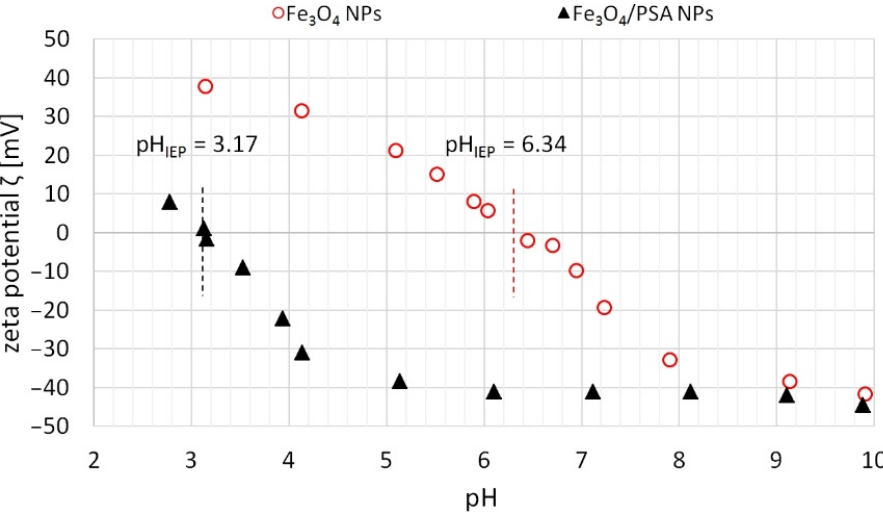
Figure 6. Impact of the pH on the zeta potential of unmodified magnetite (Fe 3 O 4 NPs) and PSA-modified magnetite (Fe 3 O 4 /PSA NPs).